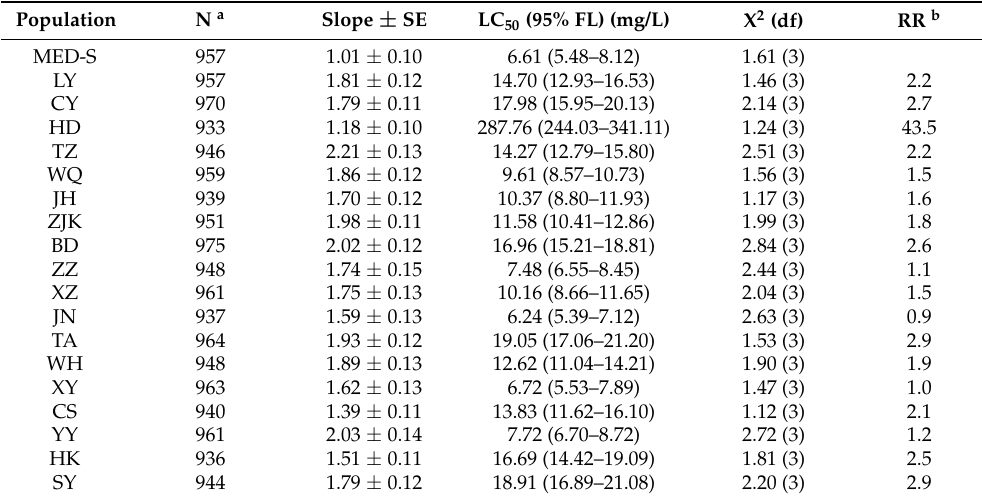
Table 2. Afidopyropen susceptibility of field-collected B. tabaci populations from China.